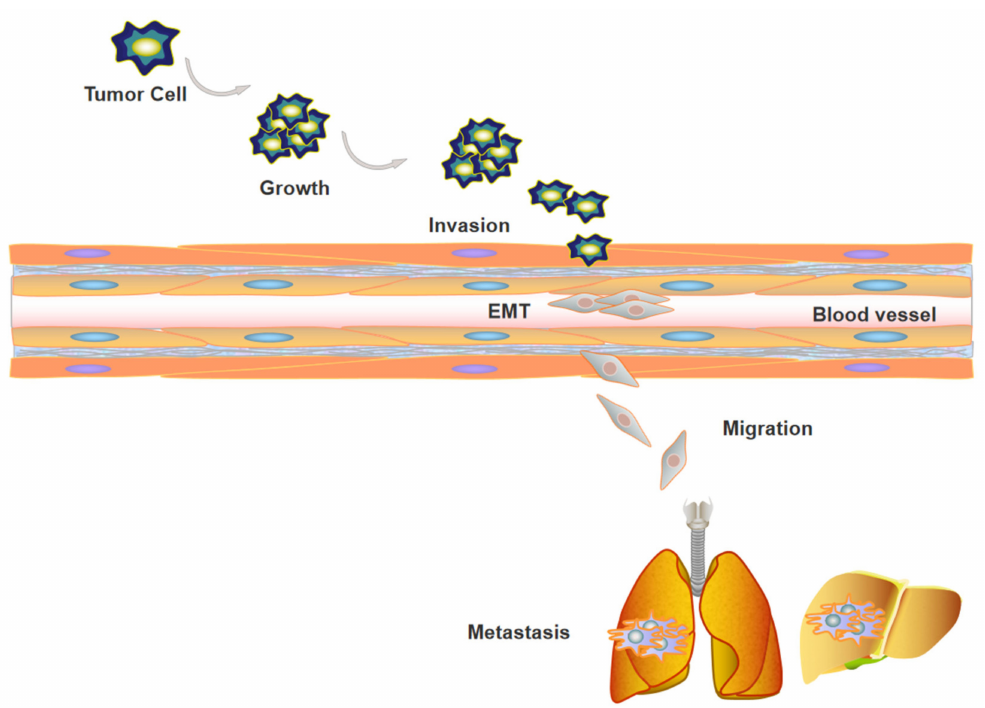
Figure 1. Tumor metastasis contains a series of events. First, clonal expansion of tumor cells was observed, and tumor cells adhere to and invade into basement membrane, during this process, tumor cells proceed EMT. Subsequently, tumor cells extravasate to blood vessels, migrate to distant organs, and form metastatic tumors